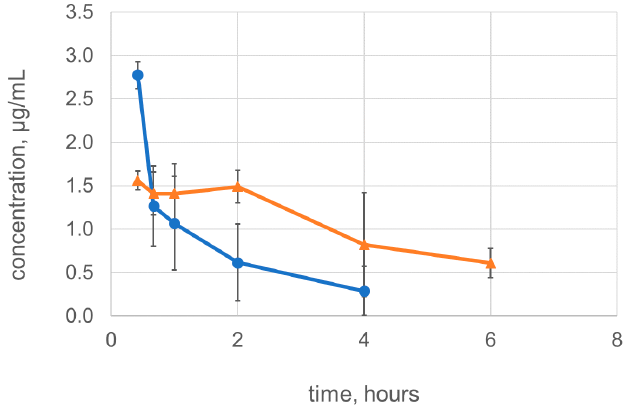
Figure 4. Residual concentrations of lysostaphin (blue, circles) and Lst-HDD (orange, triangles) in rat plasma. The mean values over n = 4 rats are shown, error bars represent standard deviation.